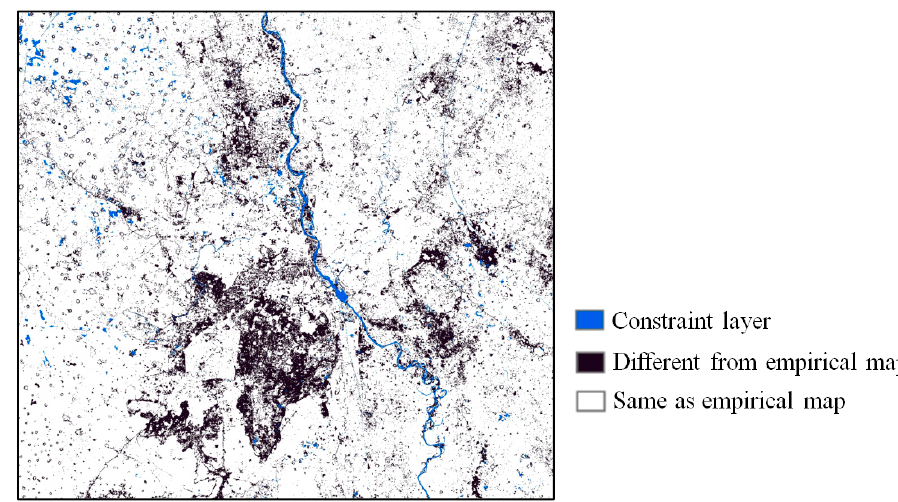
Figure 8. Map showing the spatial differences between the predicted map and the empirical map in 2017.